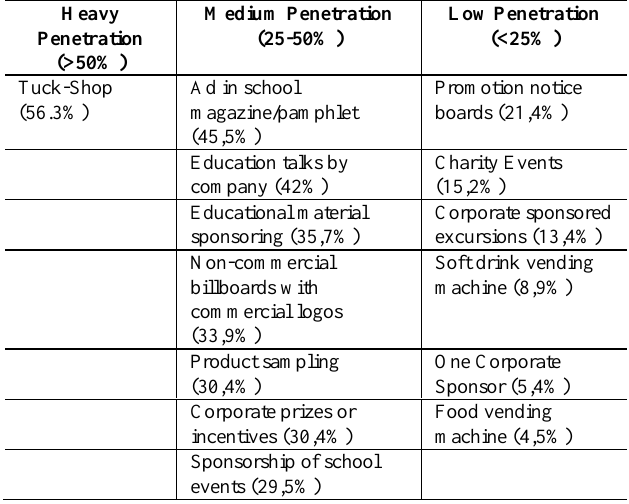
Table 3: The presence of commercial activities in South African primary schools Heavy